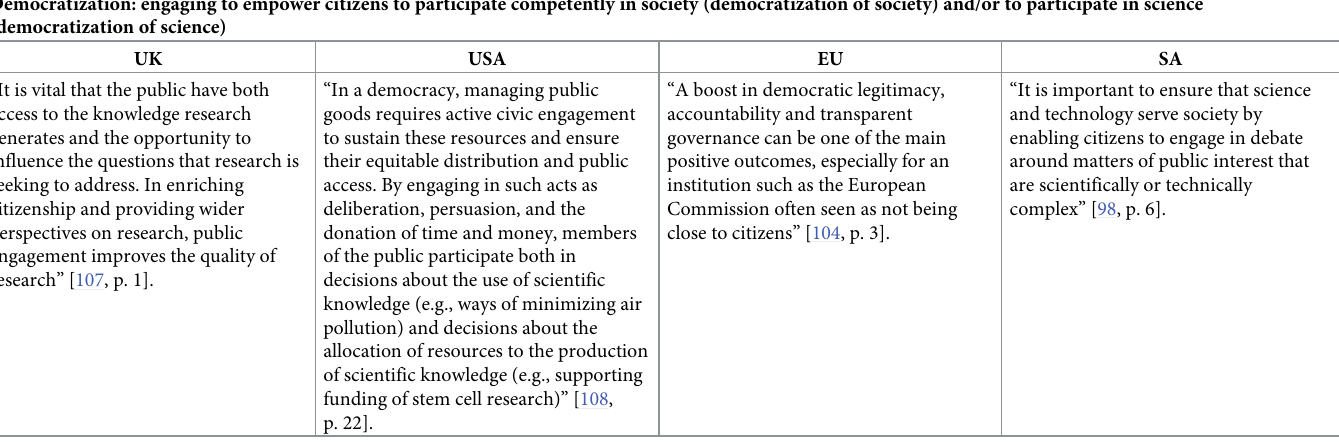
Table 4. Democratization as motivation for engagement in policy documents.